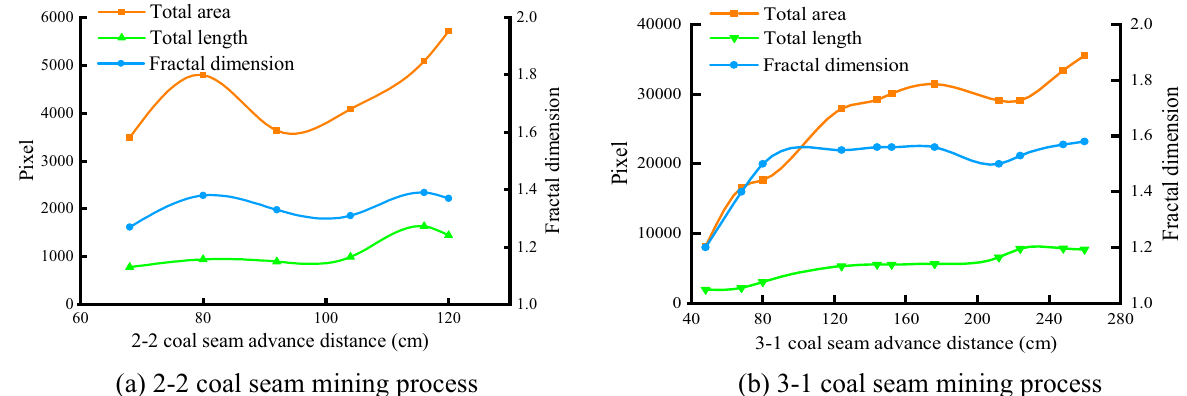
face. The blue line is the fracture analysis dimension, the orange line is the fracture area, and the green line is the fracture length. It can be seen from Fig. 8 that, except for individual spanning stages, the fractal dimension of the fracture, the length and area of the fracture—increase or decrease synchronously with the advancement of the working face, showing a strong correlation. In the process of 2–2 coal seam mining, the fracture fractal dimension, total fracture length, and total area curve show a trend of first increasing, then decreasing, and then increasing with the advancement of the working face, and the overall change is relatively gentle. When the basic top of the 2–2 coal seam collapsed for the first time, the fractal dimension of the fissure was 1.27, the length of the fissure was 783 pixels, and the area of the fissure was 3489 pixels, all of which were the lowest values in the whole mining stage. When the overlying rock collapsed for the last time, the fractal dimension of the fracture reached its maximum value of 1.39 in the mining stage, the total length of the fracture was 1635 pixels, and the total area of the fracture was 5083 pixels. The fluctuation of data lines is due to the inherent randomness of fracture development, and the degree of rock layer compaction in each caving stage is different, which makes the development of fissures different in each caving stage. In the 3-1 coal seam mining stage, when the gobs of the upper and lower coal seams are penetrated, the total length and total area of the fissures increase, the fractal dimension of the fissures increases from 1.4 to 1.5, the total fissure area increases from 16,638 pixels to 17,707 pixels, and the total length from 2217 to 3071 pixels, the